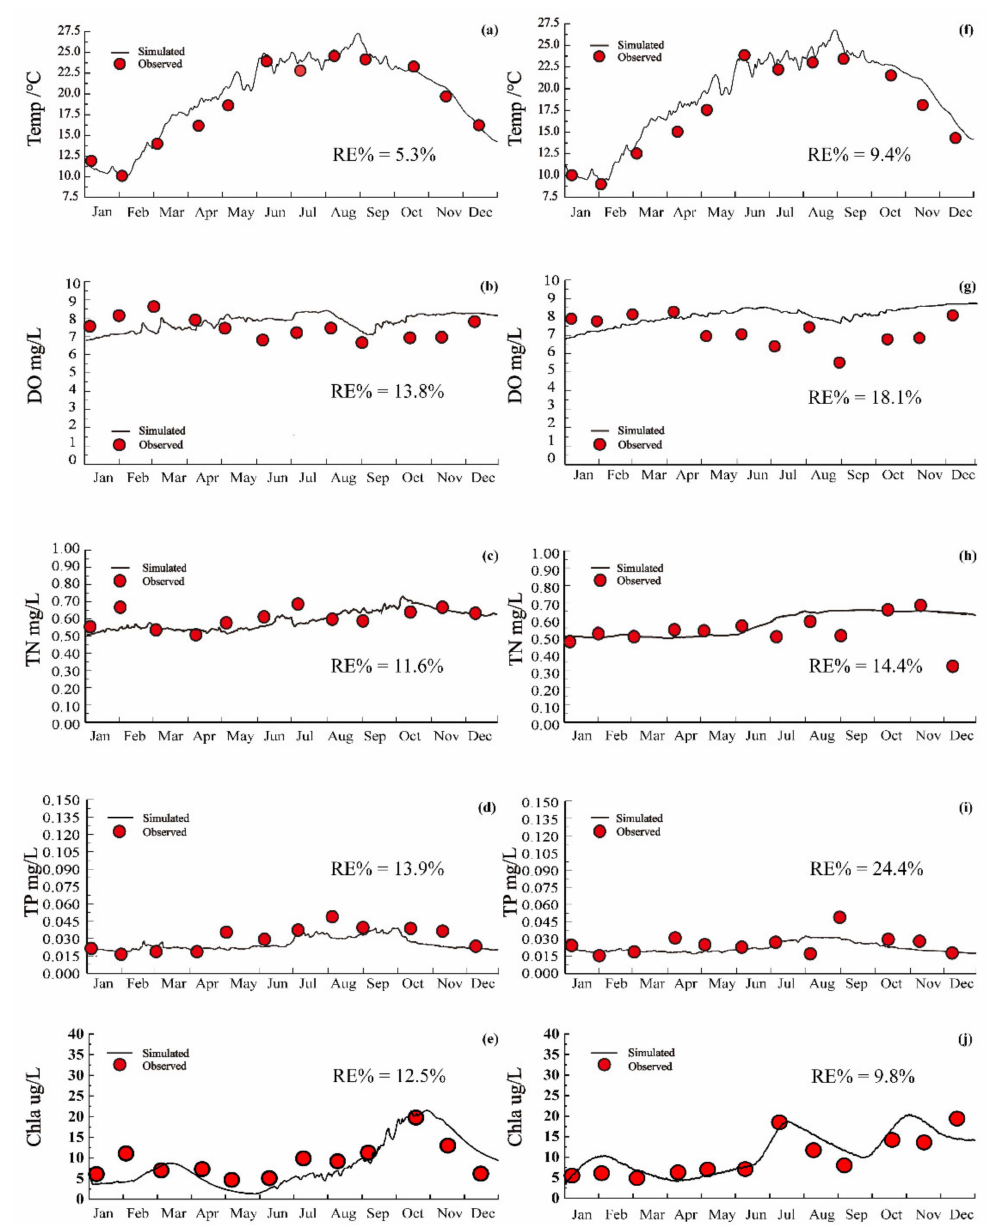
Figure 4. Calibration of water quality in Lake Erhai: ( a – e ) temp/DO/TN/TP/Chla in Southern lake center; ( f – j ) temp/DO/TN/TP/Chla in northern lake center. 3.3. The Seasonal Dynamic of Phytoplankton Biomass and Net Primary